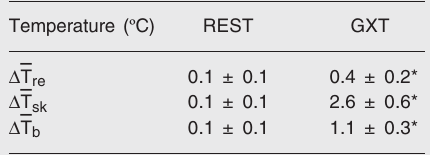
Table 2. Variation of body temperatures at rest and during graded exercise tests until